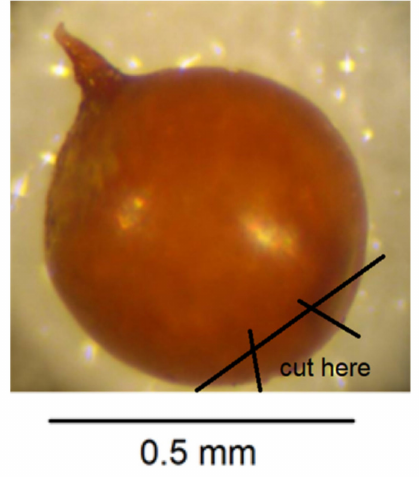
Figure 6. Make two more cuts to the excised section of cyst